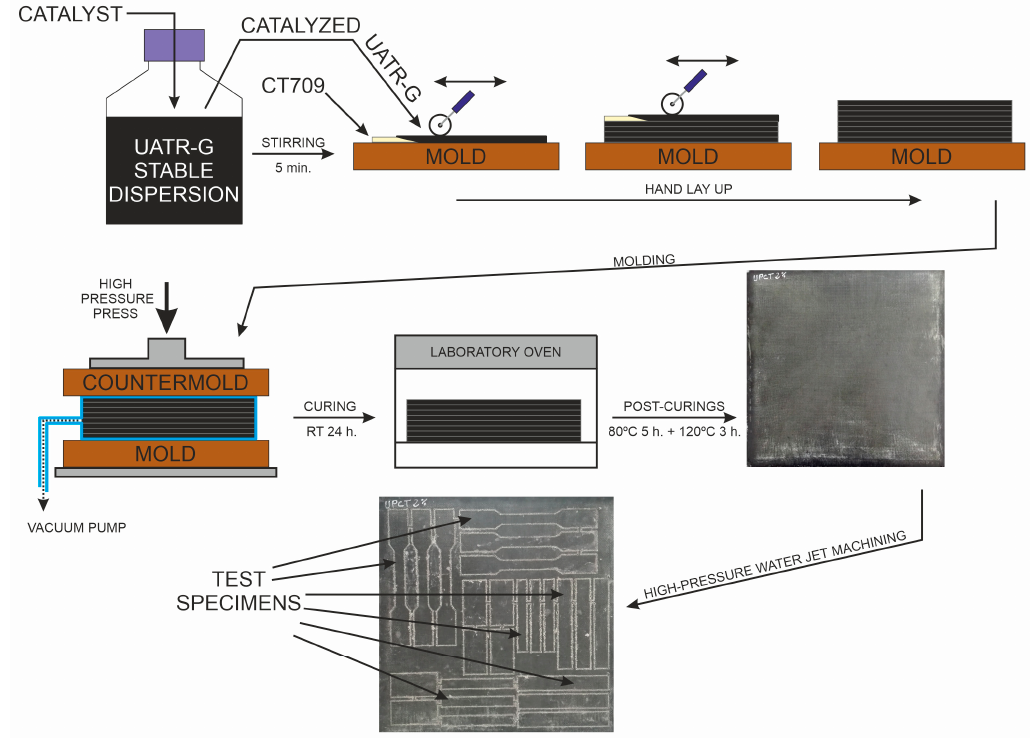
Figure 3. Schematic representation of the preparation procedure for UATR-G / aramid nanocomposites. RT = Room Temperature.